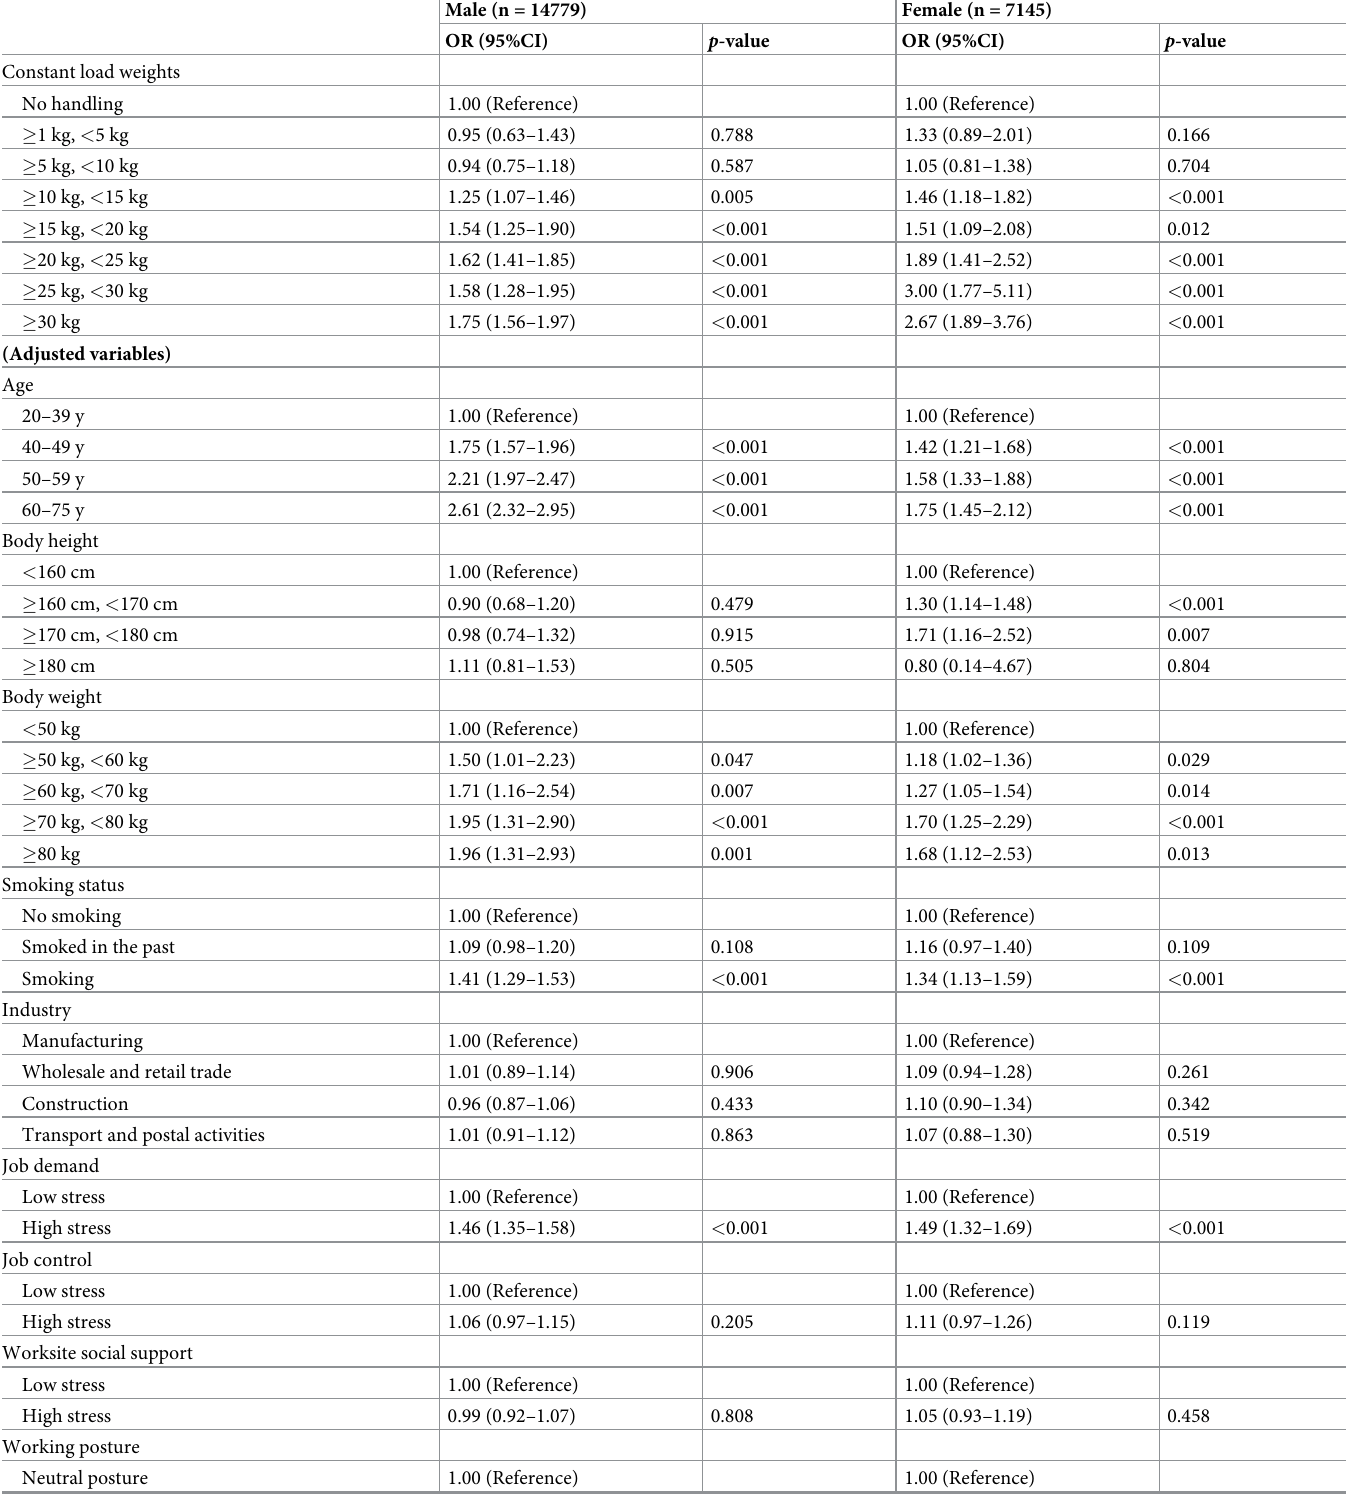
Table 4. Association of severe low back pain with weight limit as constant load weights from multiple logistic